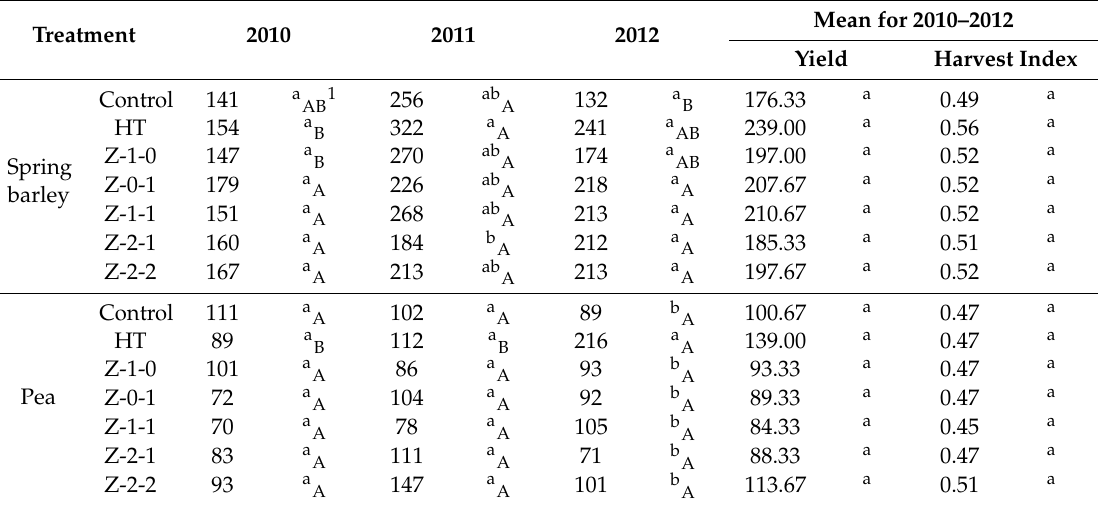
Table 1. Grain yield of spring barley and pea (g m − 2